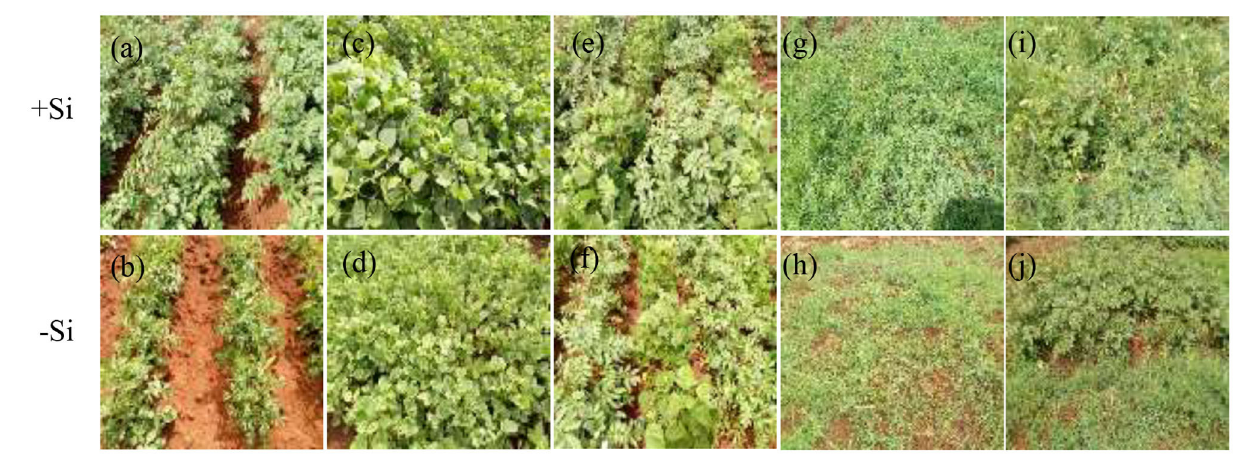
FIGURE 4 | Effect of Si application and legume intercropping on crop growth. (a,b) sole potato, (c,d) sole dolichos, (e,f) potato-dolichos intercrop, (g,h) sole vetch, (i,j) potato-vetch intercrop, with Si ( + Si) and without Si (–Si) applications,